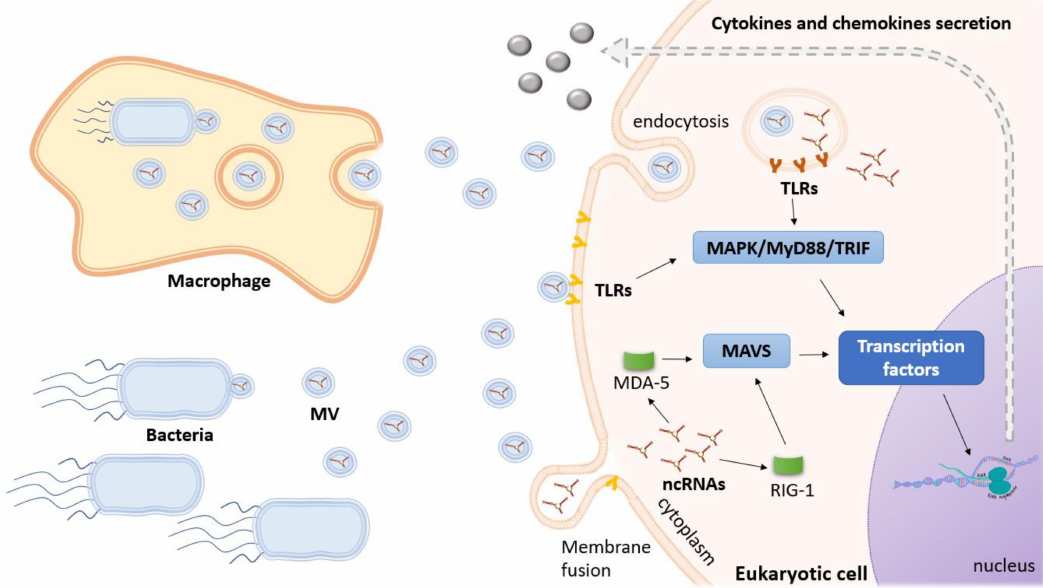
Figure 2. Activation of innate immune receptors by bacterial membrane vesicles and their RNA content. When bacterial EVs released by extracellular or intracellular bacteria reach the target cells, the sensing of these vesicles and / or its RNA content could occur at di ff erent intracellular locations. The pathogen-associated molecular patterns (PAMP) on the outside of these vesicles can induce the host innate immune response by activating the toll-like receptor and MAP-kinase (TLR / MAPK) signaling pathway, leading to the activation of transcription factors that induce the production of inflammatory mediators. The RNA cargo of EVs internalized by endocytosis can also be released and sensed by endosomal receptors. These receptors signal through the adaptor molecules MyD88 or TRIF, resulting in the activation and nuclear translocation of transcription factors that will induce production of inflammatory mediators and type I interferons. RNAs delivered into the cytoplasm after fusion of EVs with the host cell plasma membrane might be sensed by cytoplasmic RNA sensors such as RIG-I and MDA-5. Engagement of these receptors triggers signaling through the adaptor protein MAVS, which signals to induce the production of inflammatory mediators and type I